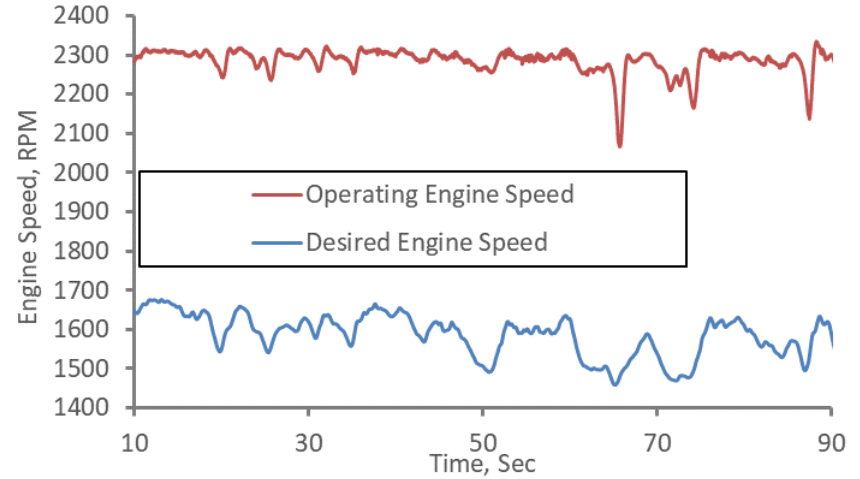
Figure 18. Measured engine speed and desired engine speed during plowing operation without the control